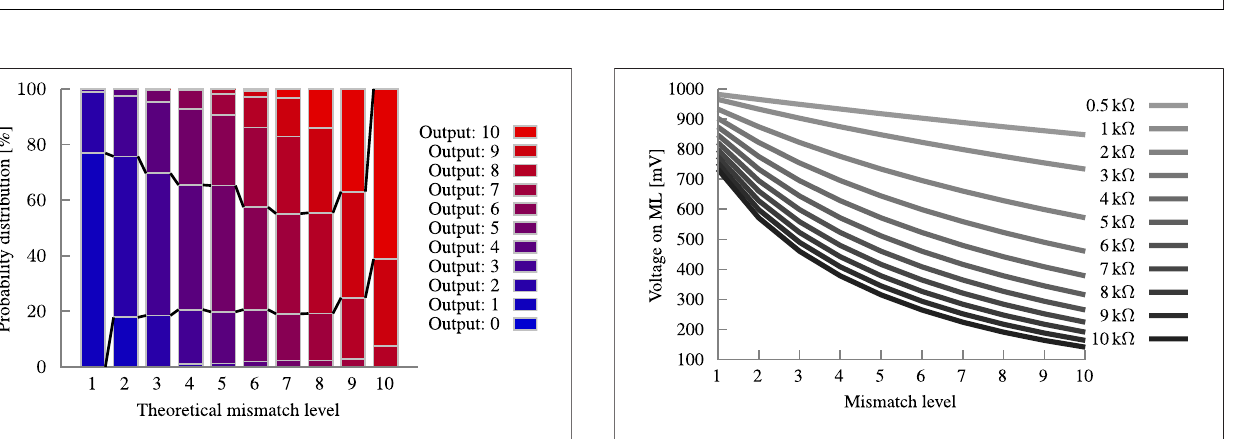
FIGURE 11 | Analysis of the resistance connecting the supply voltage and the ML. It shows the development of V ML over the different mismatch levels for a block size of 10